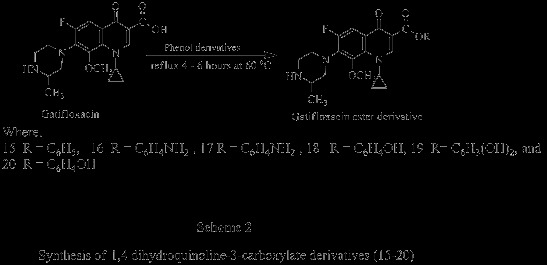
Synthesis of 1,4 dihydroquinoline-3-carboxylate derivatives (15–20).